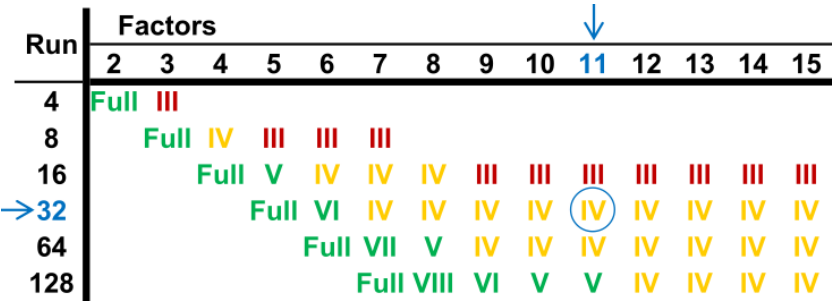
Figure 7. Factorial design: experimental resolutions. This work considers 11 factors and 32 experi- mental runs. Source: own authors.